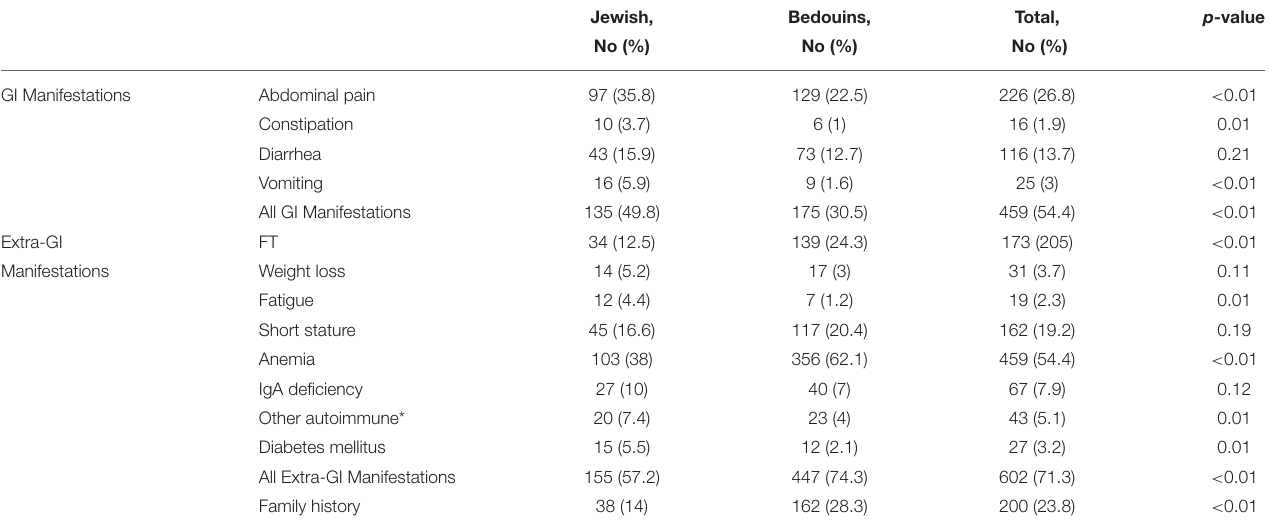
TABLE 2 | Clinical data at diagnosis among the different ethnic groups.